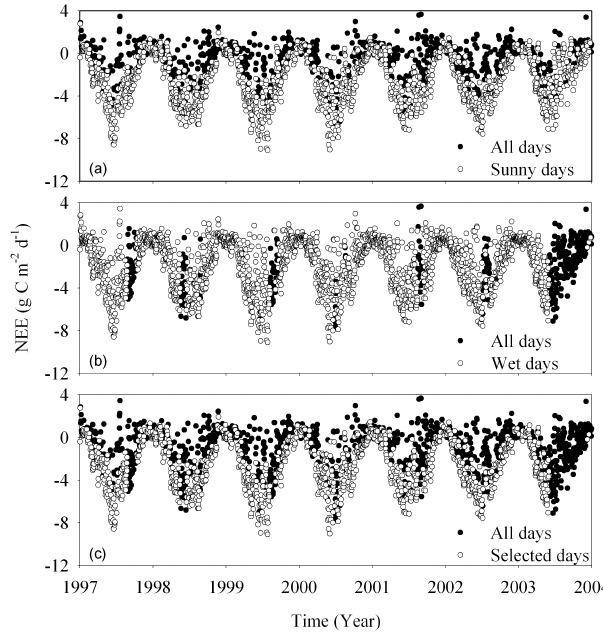
Fig. 1. Comparison on net ecosystem exchange (NEE) between all days and sunny days (a) and wet days (b) and selected days ex- cluding both cloudy and drought days (c) at DE-Tha site. Negative values on y-axes indicate that carbon is absorbed by the ecosystem, while positive values indicate that that carbon is released by the ecosystem to the atmosphere.